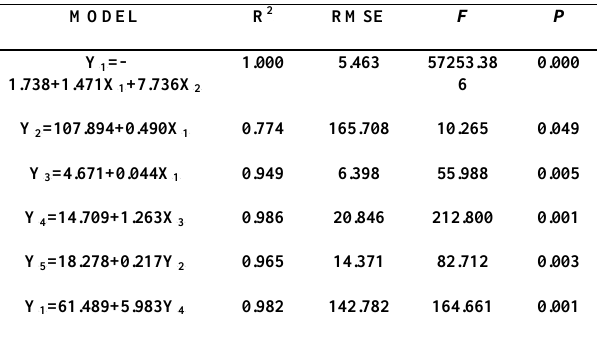
Table 2 Prediction results using multiple linear